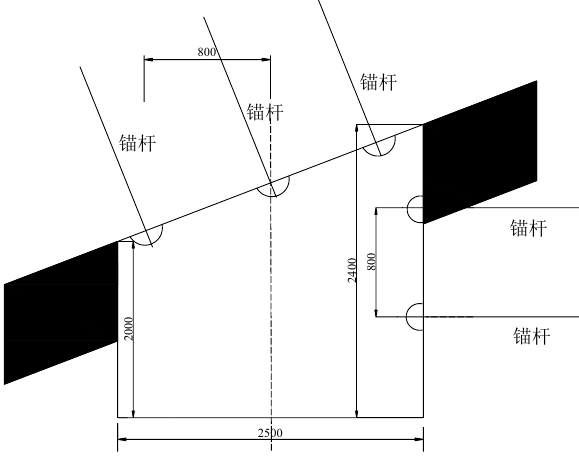
Figure 2. Bolt mesh section support of air roadway in 5449 working